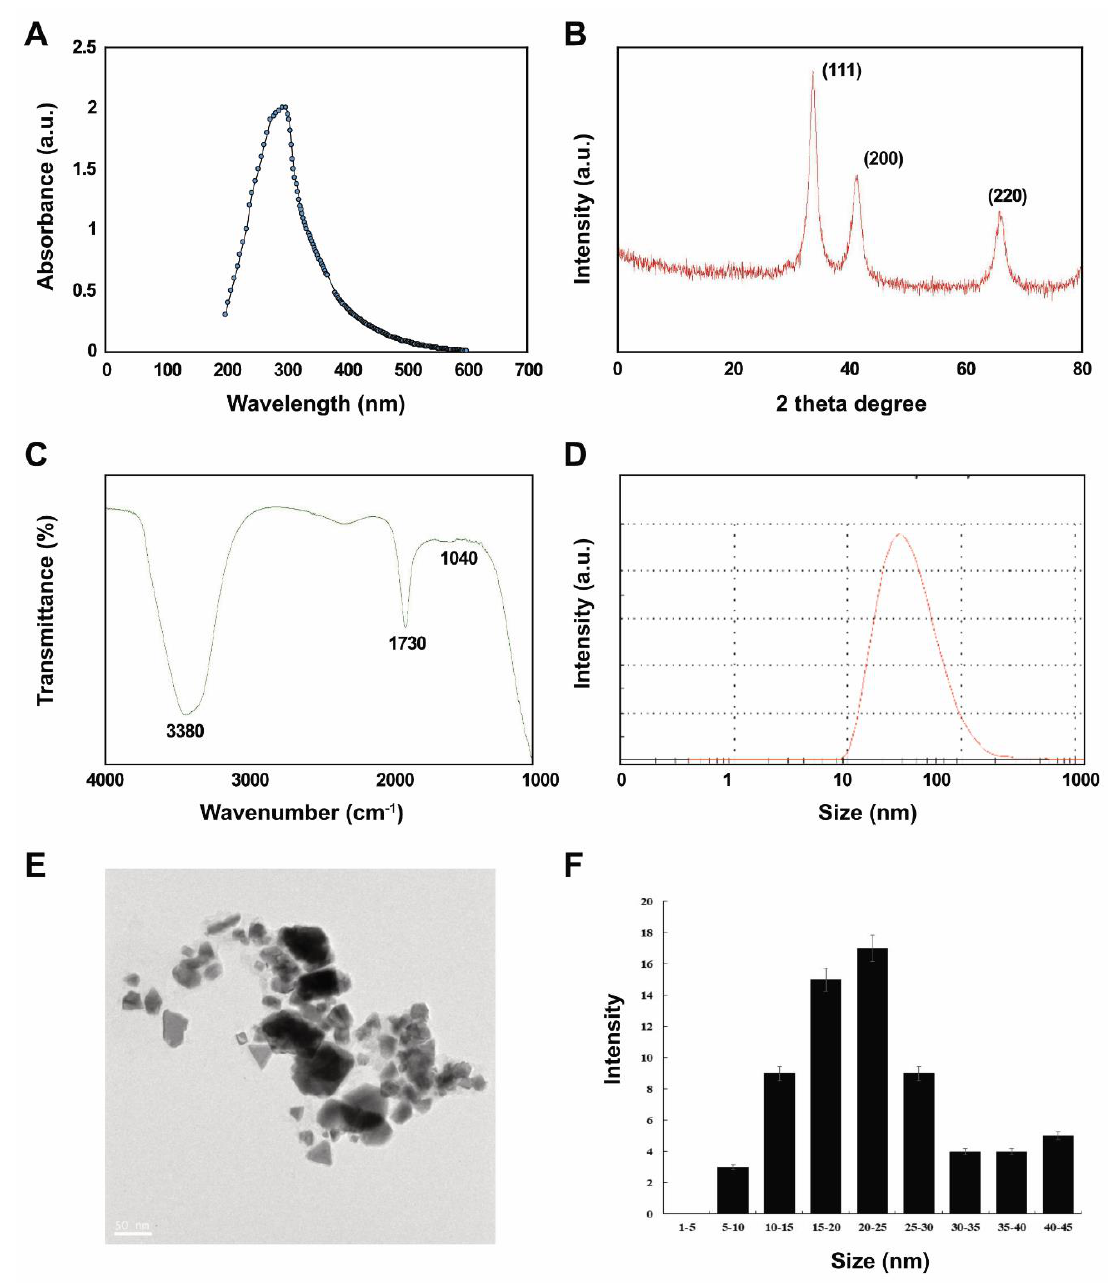
Figure 1. Synthesis and characterization of platinum nanoparticles (PtNPs) using lycopene. ( A ) Absorption spectra of lycopene-mediated synthesis of PtNPs. ( B ) X-ray diffraction (XRD) patterns of PtNPs. ( C ) Fourier-transform infrared (FTIR) spectra of PtNPs. ( D ) Size distribution analysis of PtNPs using dynamic light scattering (DLS). ( E ) TEM images of PtNPs. ( F ) Histograms showing particle size distribution. At least three independent experiments were performed for each sample, and reproducible results were obtained. The data represent the results of a representative experiment.